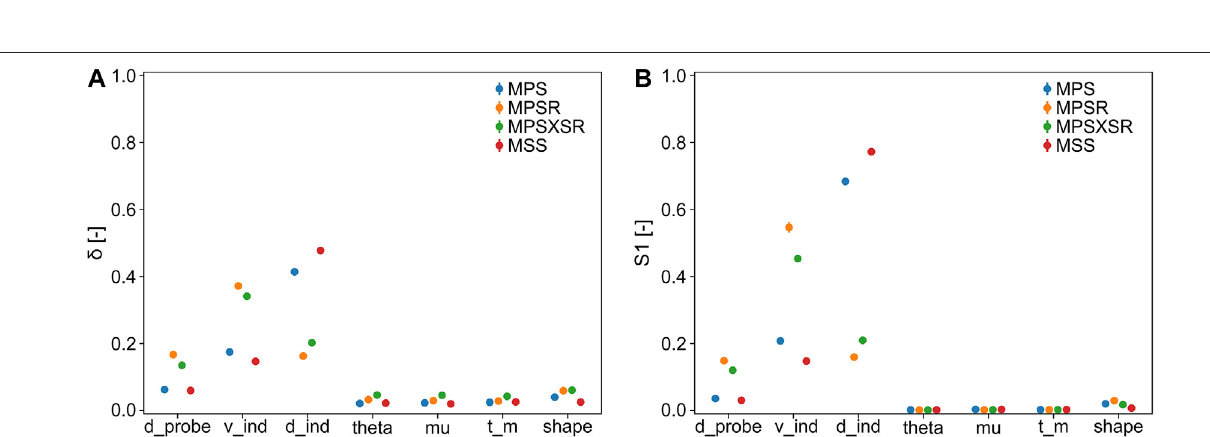
FIGURE 4 | Outcome of the MCS performed on the surrogate of the porcine brain FE model. The variability of the CC injury metrics (i.e., 95th percentile of MPS, MPSR, MPSXSR, and MSS in the ROI) is shown as a function of the input parameters. The solid line represents the median while the shaded area delimits the 90% con fi dence interval.